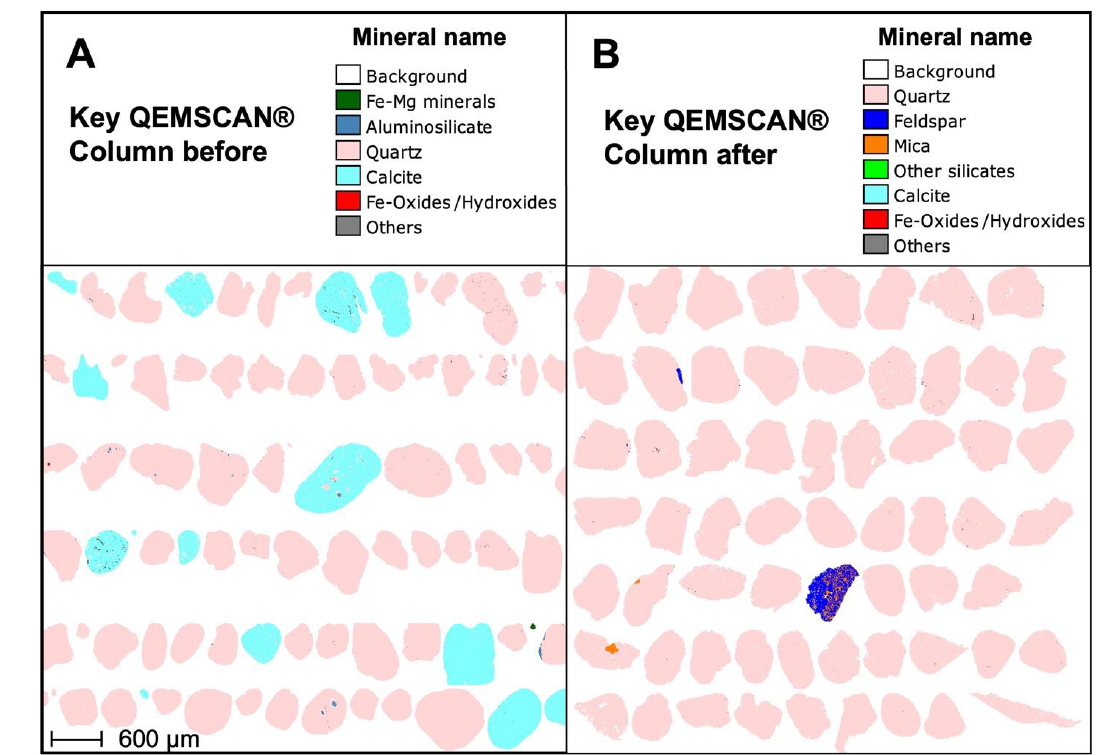
Figure 8. Particle image of column sand before ( A ) and after ( B ) calcite dissolution.